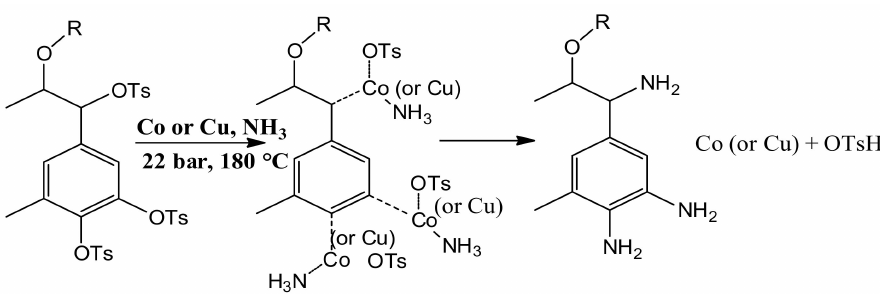
Figure 4. Proposed mechanisms of cobalt/copper catalyzed amination